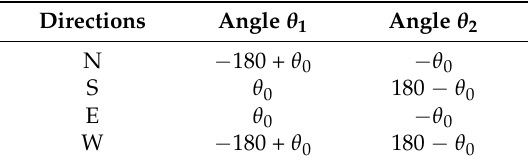
Table 5. Calculation of angles θ 1 , θ 2 , depending on the